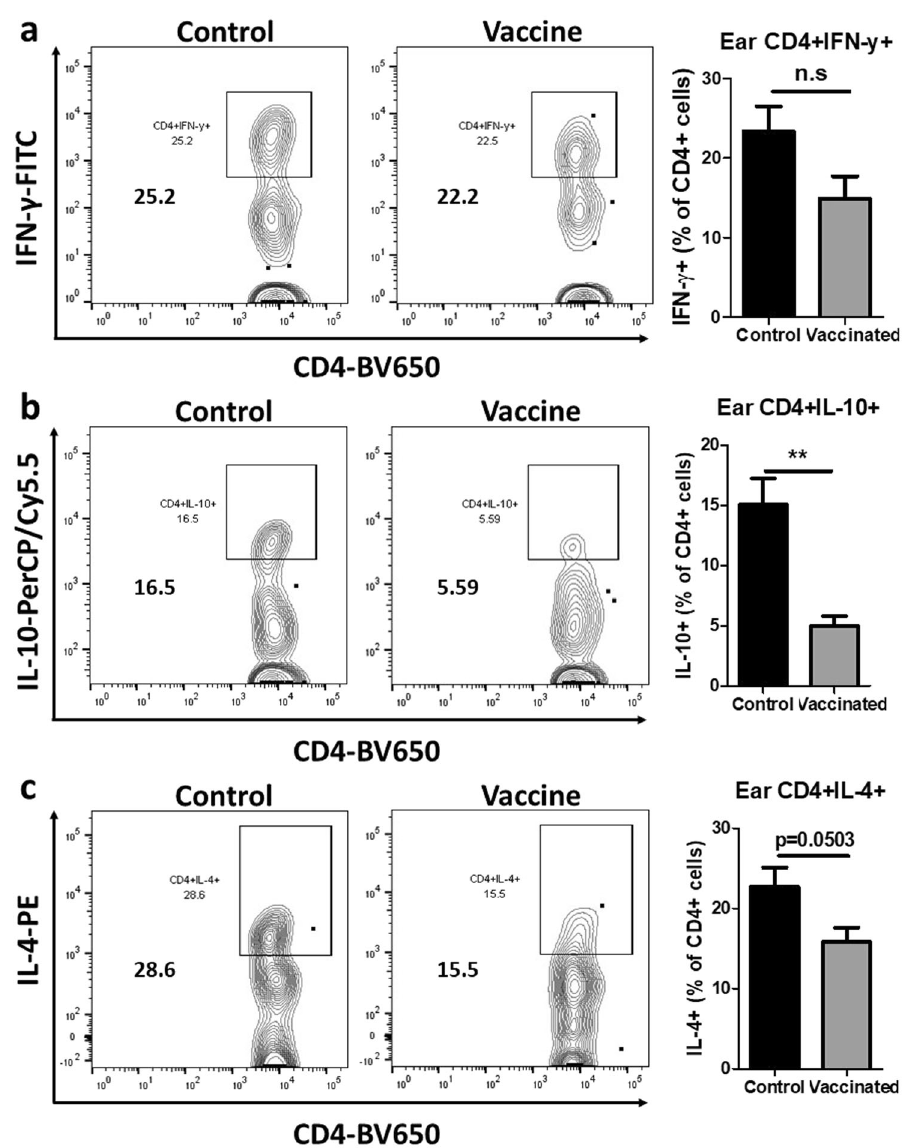
Fig. 7 LmexCen − / − immunization mediates diminished Th2 induction in BALB/c ears challenged with Lmex WT. a Percentage of CD4 + IFN- γ + T cells in the ear of vaccinated and control mice at 10 wpc analyzed via fl ow cytometry. b Percentage of CD4 + IL-10 + T cells in the ear of vaccinated and control mice at 10 wpc analyzed via fl ow cytometry. c Percentage of CD4 + IL-4 + T cells in the ear of vaccinated and control mice at 10 wpc analyzed via fl ow cytometry. Data show one representative experiment out of four independent experiments and show mean ± SEM, N = 5 for each group at each time point. Unpaired two-tailed Student ’ s t -test was performed to compare statistical signi fi cance. A P -value < 0.05 was considered signi fi cant. In all panels * represents P ≤ 0.05, ** represents P ≤ 0.01, and *** represents P ≤